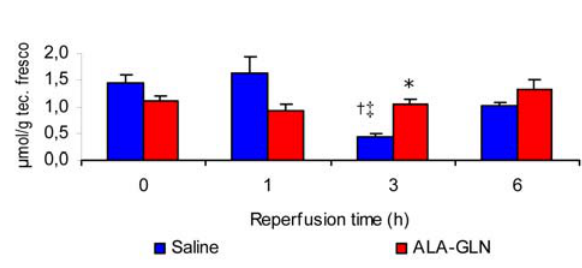
FIGURE 7 - Kidney ATP concentrations in saline and L-alanyl-glutamine treated rats.